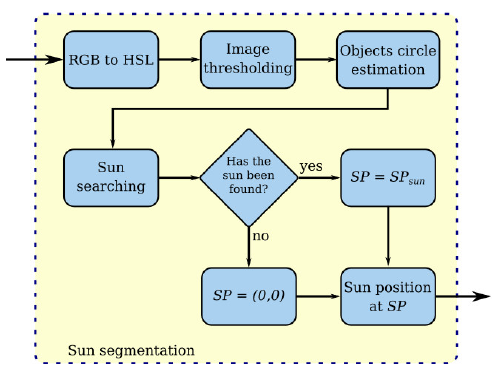
Figure 4. Sun segmentation based on image